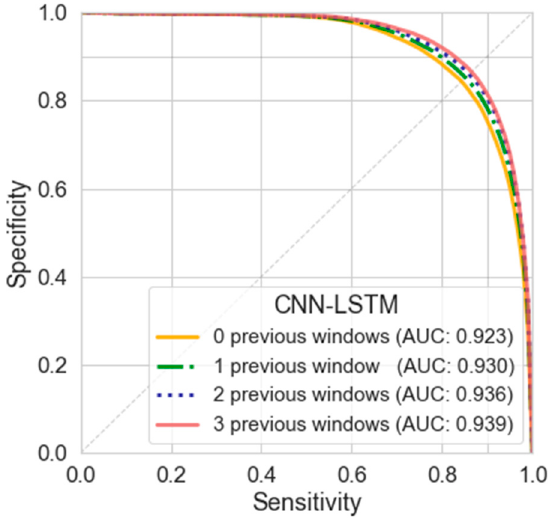
Figure 7. Specificity vs. sensitivity curves, and area under the curve (AUC) when including previous windows in the CNN-LSTM model, using a LOSO evaluation with FFT data representation and 75% overlap.